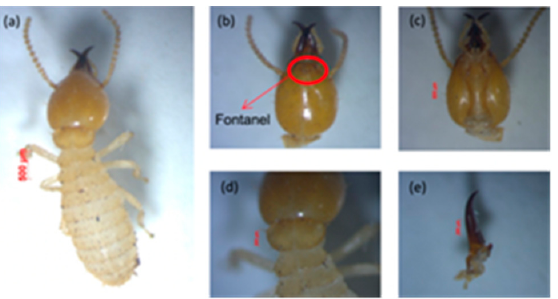
Figure 4. View of Coptotermes sp.: ( a ) body shape of soldier, ( b ) head with antenna and fontanelle, ( c ) postmentum, ( d ) pronotum, and ( e ) left mandible.